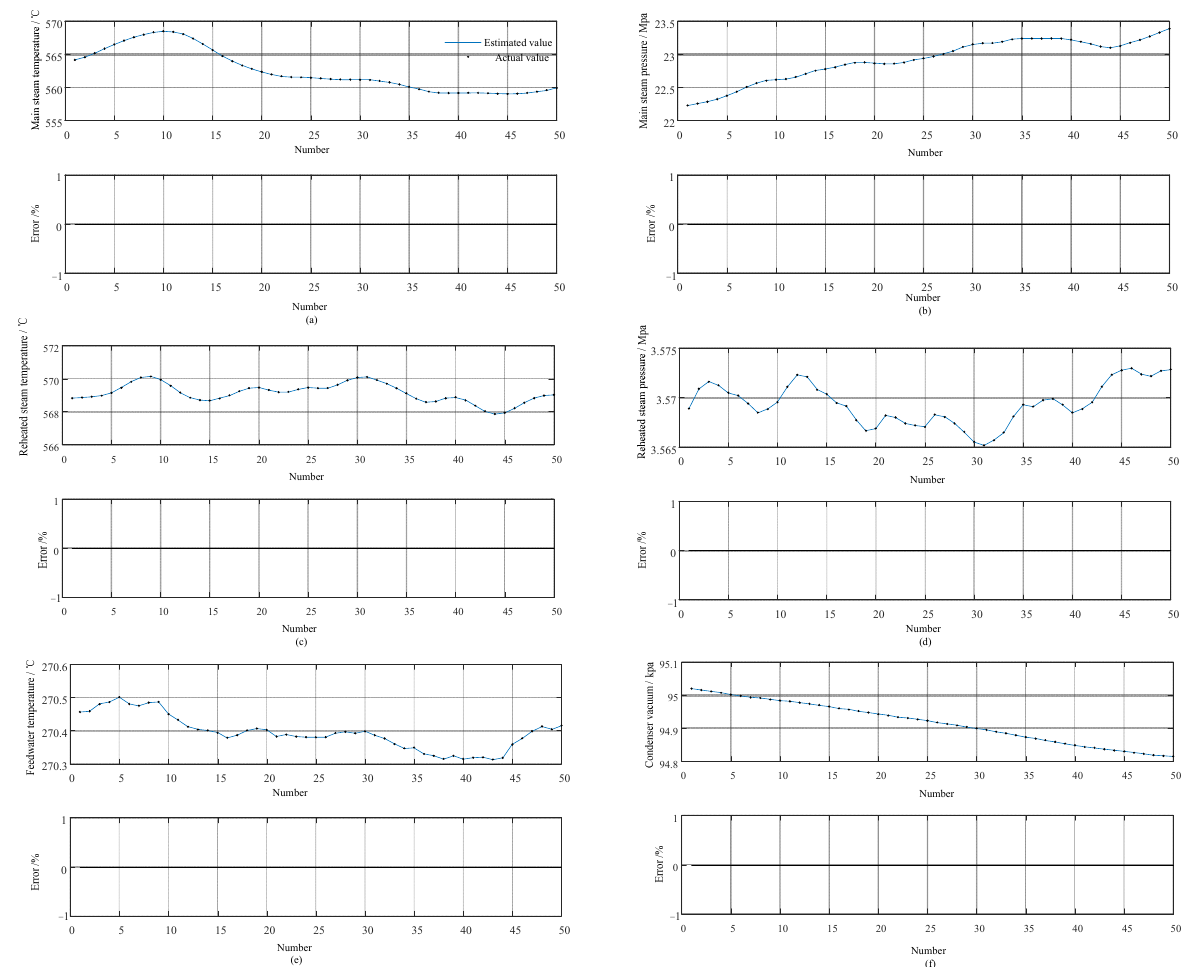
Figure 5. ( a ) The model training results of main steam temperature. ( b ) The model training results of main steam pressure. ( c ) The model training results of reheated steam temperature. ( d ) The model training results of reheated steam pressure. ( e ) The model training results of feedwater temperature. ( f ) The model training results of condenser vacuum.